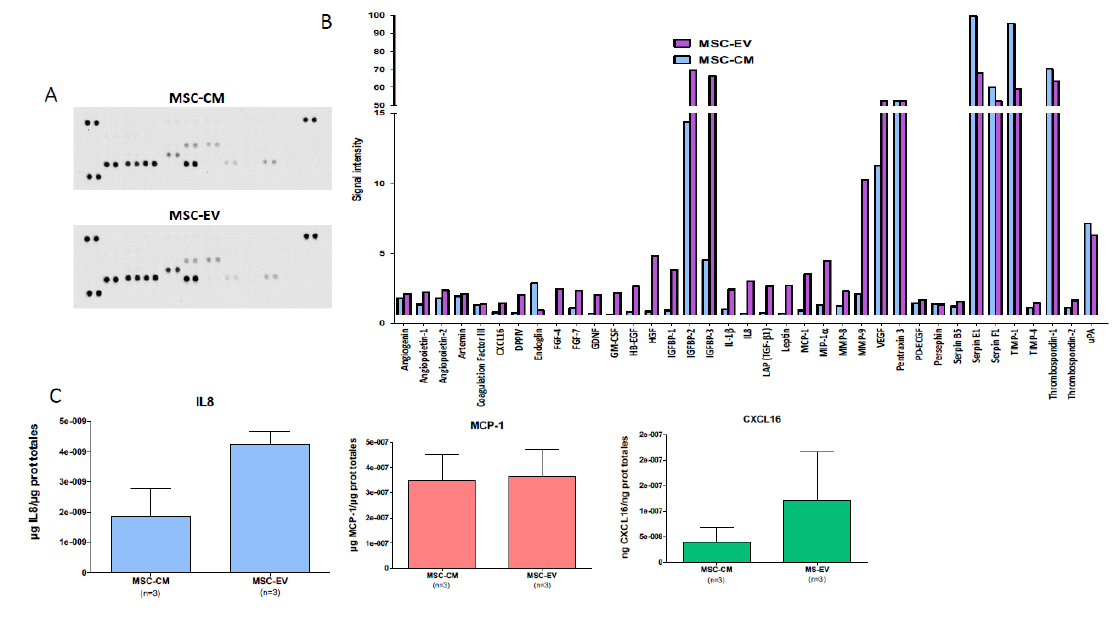
Figure 9. MSC-EVs and MSC-CM protein composition . ( A ) Profiling of angiogenesis-regulating proteins secreted by MSC-EV or MSC-CM samples obtained with Proteome Profiler Human Angiogenesis Array Kit (R&D). At the top, representative image of dot blot and at the bottom, graph showing pixel density of dot blot of each protein normalized to positive spot pixels. ( B ) Profiling of cytokines secreted by MSC-EV or MSC-CM samples obtained with Proteome Profiler Human XL cytokine Array Kit (R&D). At the top, representative image of dot blot and at the bottom, graph showing pixel density of dot blot of each protein normalized to positive spot pixels ( C ): Quantification of IL8, MCP-1 and CXCL16 secreted by MSC-EV or MSC-CM samples by ELISA (mean ± SD), n = 3.